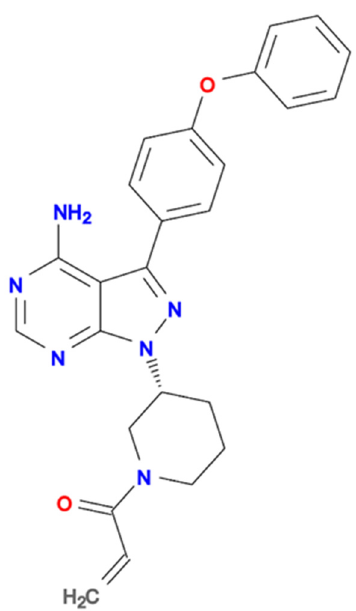
Figure 1. Ibrutinib; orally bioavailable, irreversible inhibitor of Bruton’s Tyrosine Kinase; molecular formula C25H24N6O2; chemical name 1-[(3R)-3-[4-amino-3-(4-phenoxyphenyl)pyrazolo[3,4-d]pyrimidin-1-yl]piperidin-1-yl]prop-2-en-1-one; molecular weight-440.50 Da [10,11].